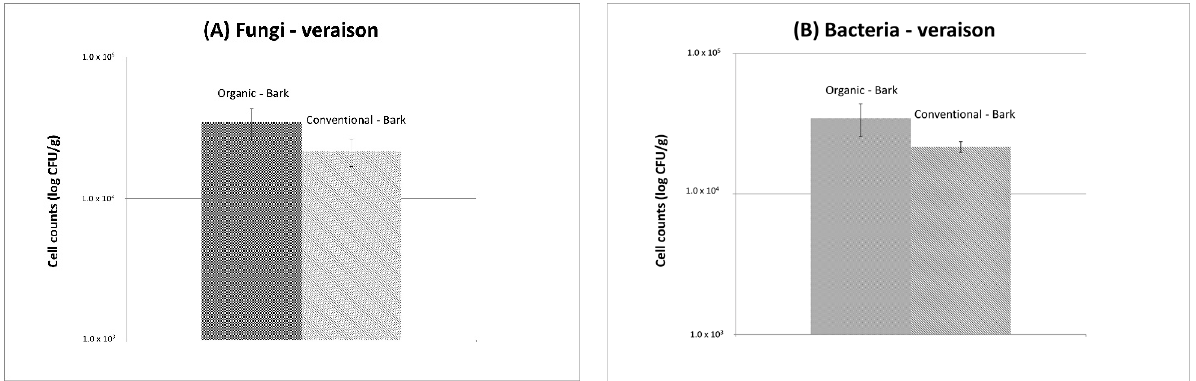
Figure 1. Microbial populations in bark samples at veraison. ( A ) Yeast/fungal populations determined on WL agar; ( B ) Bacterial populations determined by plate counts on PCA agar. Vertical bars show standard deviation (each condition represents four biological samples that were diluted and plated in triplicate).